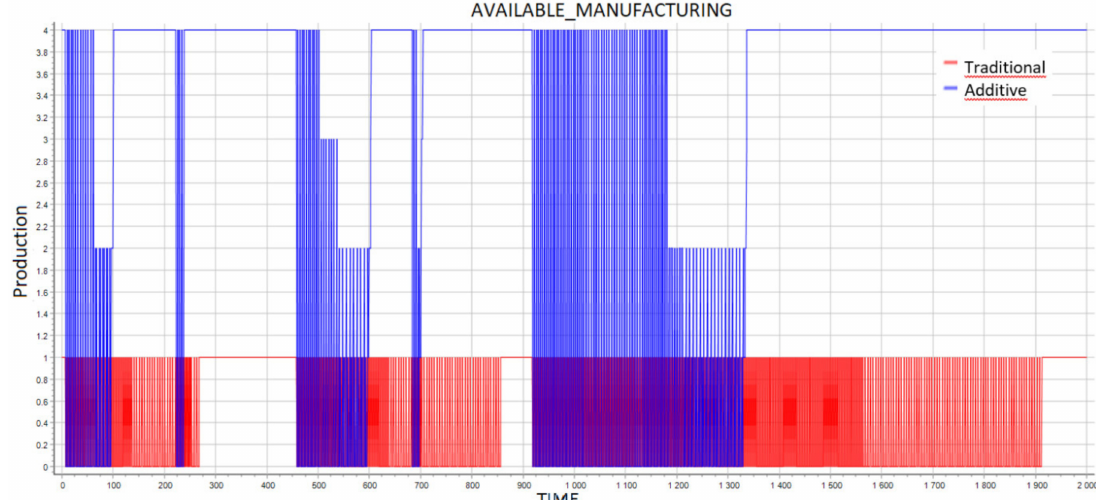
Figure 11. Production over time. Source: own elaboration. Evolution